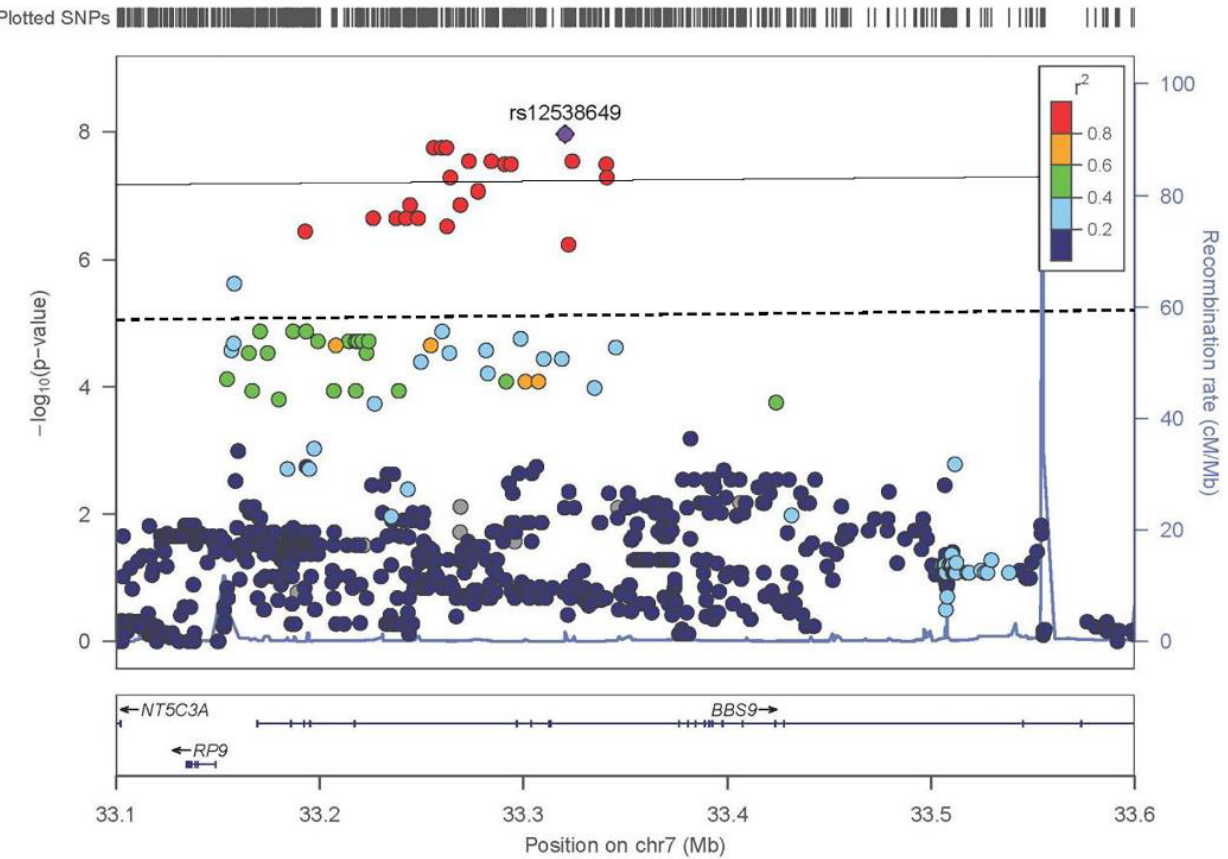
Figure 3. The results of the TDT for the metopic synostosis when only the 60 most informative trios are included. Here, the lines represent the genome-wide significant threshold of 5.00 × 10 − 8 and the genome-wide suggestive threshold of 1.00 × 10 − 5 . The LD ( r 2 ) between the most significantly associ- ated SNV rs12538649 ( p = 1.09 × 10 − 8 ) and other SNVs are indicated. LD, linkage disequilibrium; SNV, single nucleotide variant; TDT, transmission disequilibrium test. Table 3. Selected potential causal variants in chromosome 7 and 20 target regions from mNCS leave-one-out